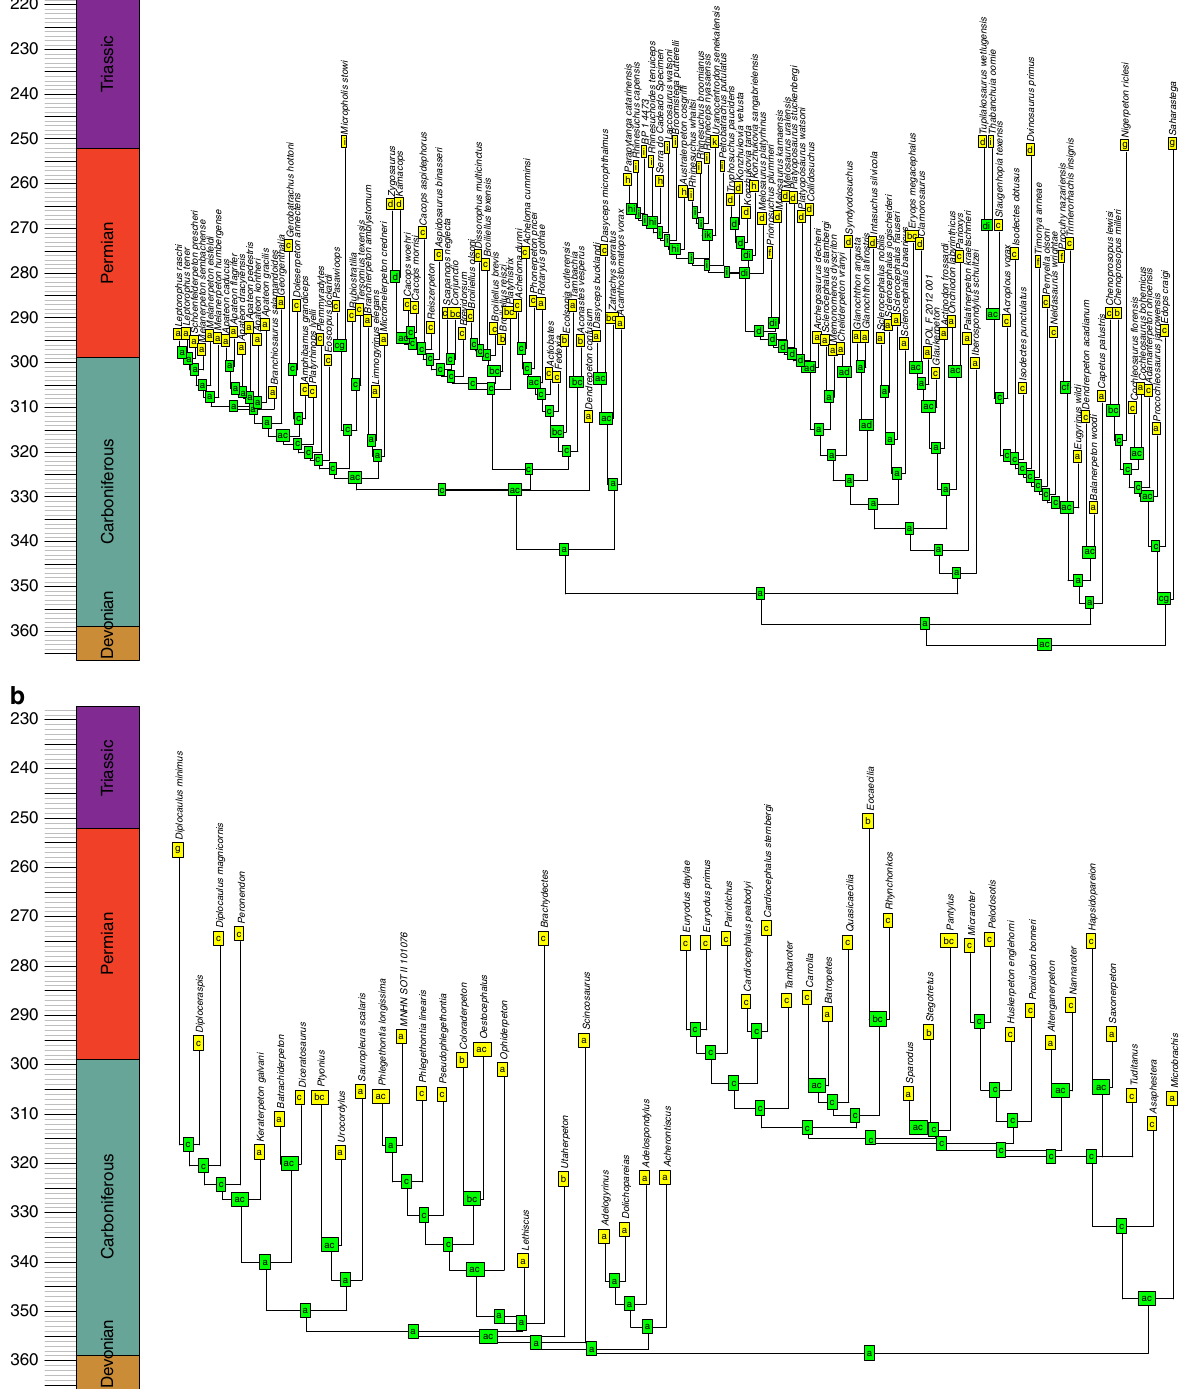
Fig. 8 Example of a reconstruction of ancestral geographic ranges of amphibians. Tree was randomly selected from the 100 time calibrated trees. a Temnospondyli. b Lepospondyli. Node labels represent the geographic range of that node with the highest probability, deduced by BioGeoBEARS. a = Western Europe; b = Western North America; c = Eastern North America; d = Eastern Europe; e = East Asia; f = Northern South America; g = Northern Africa; h = Southern South America; i = Southern Africa; j = Antarctica; k = Madagascar; l = India; m =